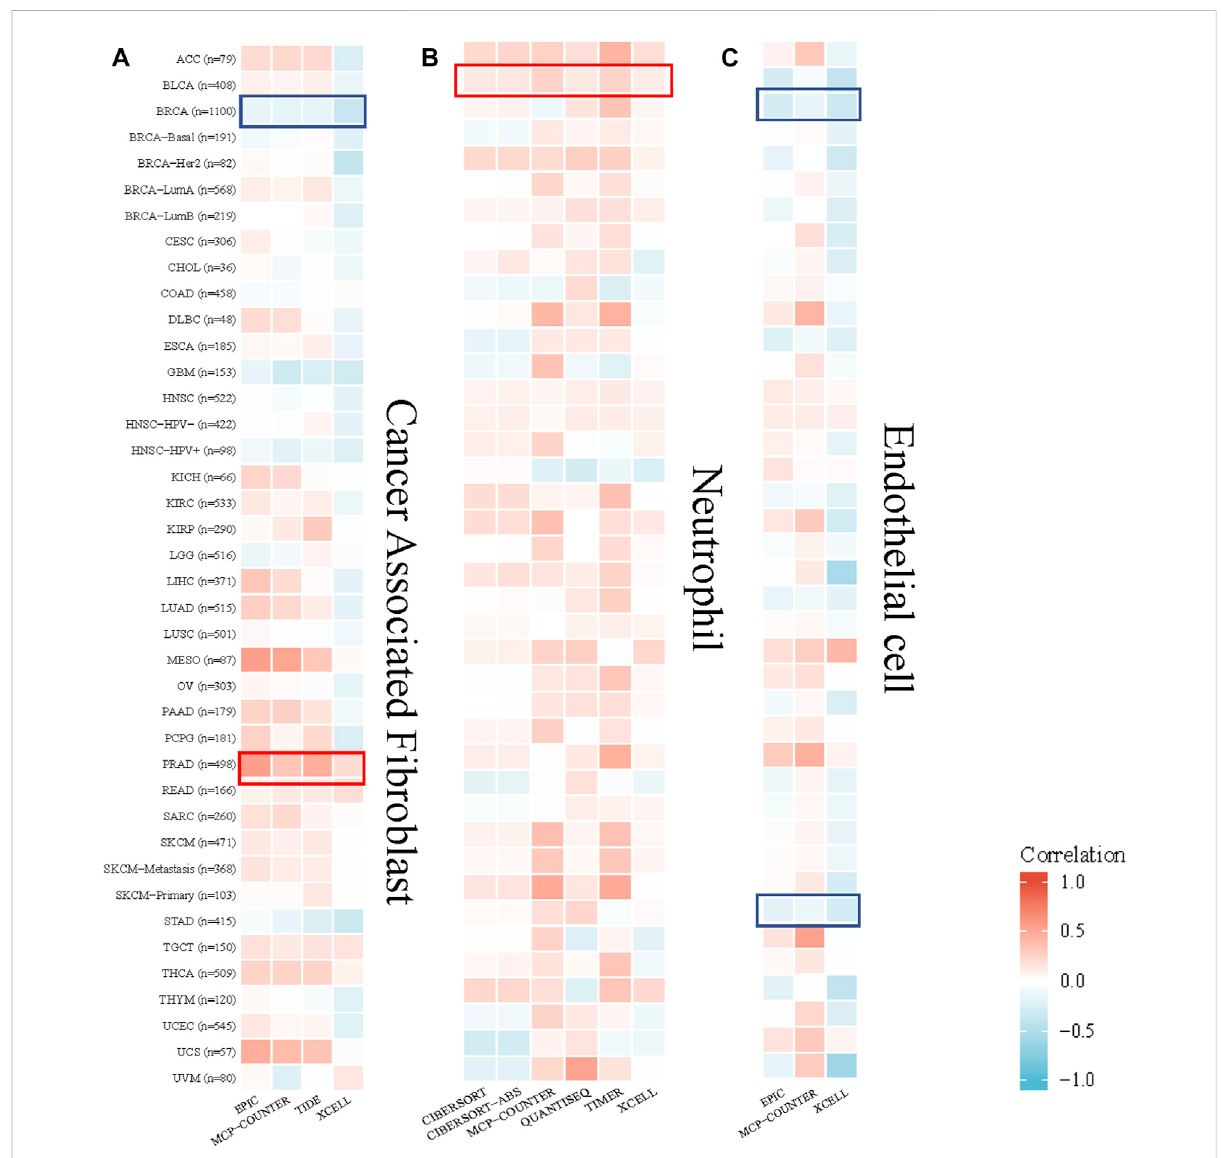
FIGURE 8 Correlation between GPSM2 expression and cancer-associated fi broblast, neutrophil and endothelial cell in fi ltration. (A – C) Heatmap of the correlation between the in fi ltration levels of cancer-associated fi broblasts, neutrophils and endothelial cells and GPSM2